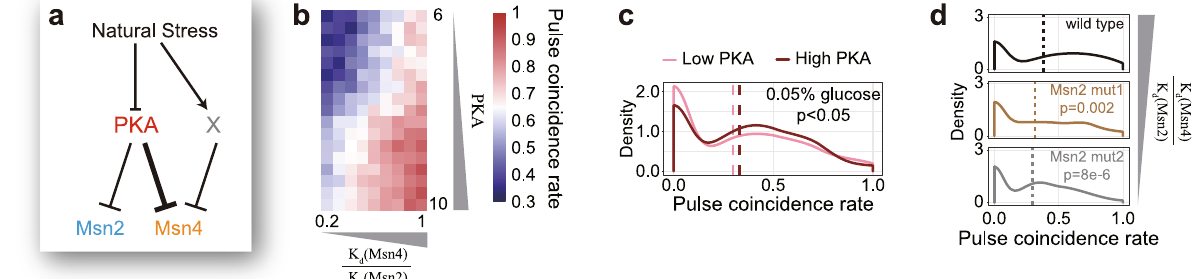
Fig. 4 Dissecting the mechanism for temporal redundancy modulation. a A proposed circuitry mechanism for achieving divergent control of Msn2 and Msn4 dynamics (see also Supplementary Fig. 9a). b Stochastic simulations of the model revealed intrinsic control (e.g., differential af fi nities to PKA) and extrinsic control (e.g., PKA activity, which is stress-dependent) of the temporal relationship between Msn2 and Msn4 dynamics. c Experimental validation for the extrinsic control of temporal redundancy through arti fi cially altering PKA level (Supplementary Fig. 10a). Elevating PKA increases pulse coincidence rate, as the model predicted (Supplementary Fig. 9d, f). Dashed lines indicate means and the p value indicates one-sided K – S test. Cell numbers are 513 and 333 for low (0.25 μ M Cu 2 + ) and high (1 μ M Cu 2 + ) PKA. d Experimental validation for the intrinsic control of temporal redundancy. Two mutants of Msn2 were generated to tune the relative af fi nity to PKA between Msn2 and Msn4 (Supplementary Fig. 10b, c) and their pulse coincidence rates were compared with wild type under glucose limitation stress (0.01% glucose, see also Supplementary Fig. 10d). Dashed lines indicate means and p values indicate one- sided K – S tests. Cell numbers are 363, 487, and 503 (top to